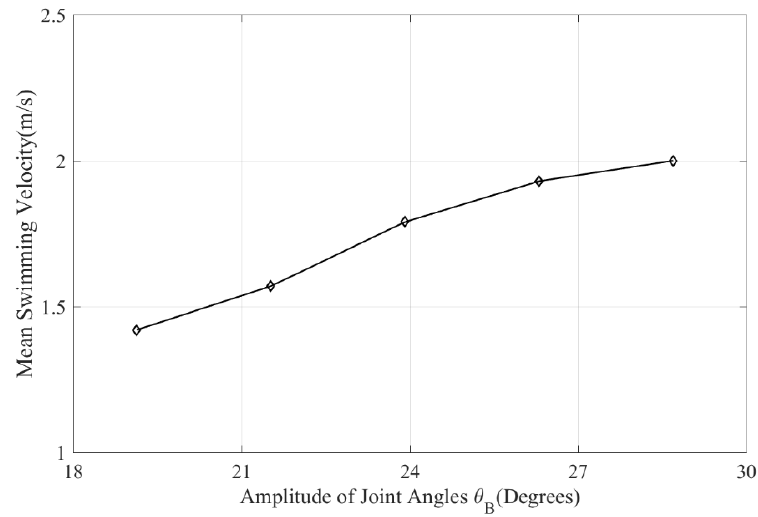
Figure 7. Mean swimming velocity of swimmer under different trunk oscillations. Table 1. Mean swimming velocity of the swimmer under different trunk